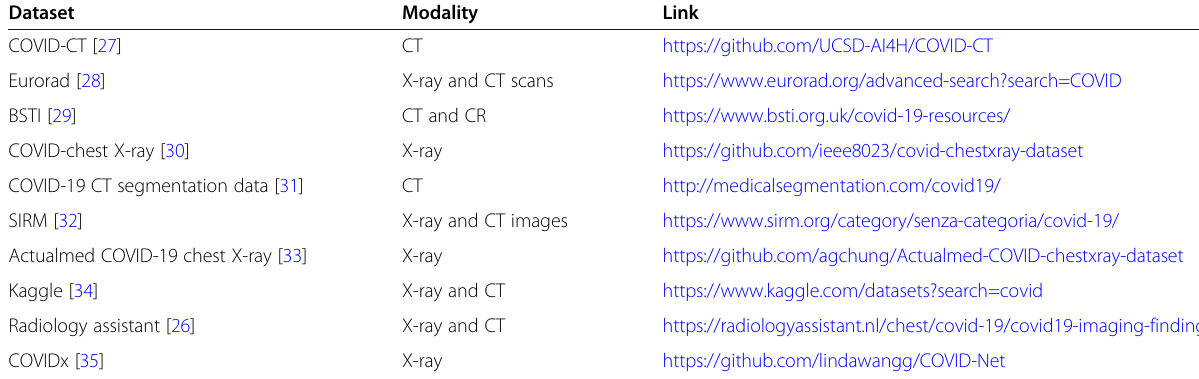
Table 1 List of COVID-19 datasets available in the public domain